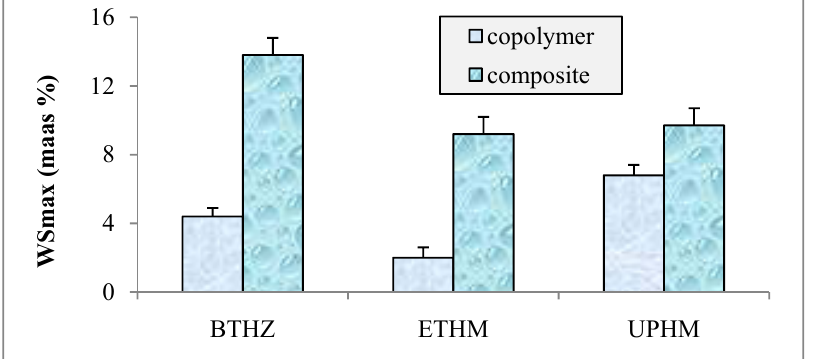
Figure 2. Maximum water sorption (WS ; mean + SD) values in BTHZ, ETHM and max UPHM copolymers and their ACP composites attained after 1 month immersion in buffered saline solutions at 23 °C. Number of specimens in each experimental group n =